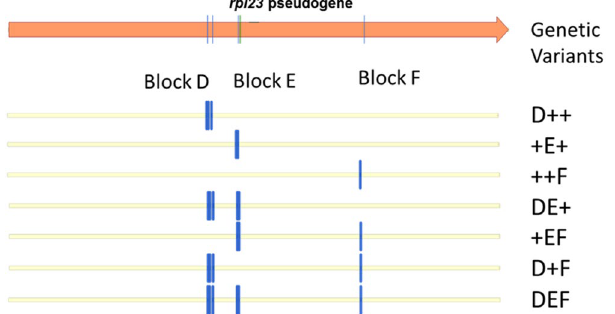
Figure 5. Representation of the potential genetic variants in the rpl23 pseudogene. D, E and F represent the polymorphic positions in the cpm rpl23 pseudogene (blocks D, E and F). + corresponds to the wild type sequence.